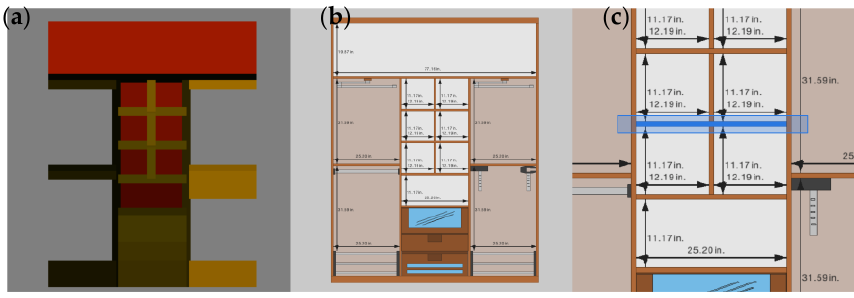
Figure 11. Expansion of the selectable surface of the several elements of a cabinet: ( a ) color information corresponding to the different selectable areas, ( b ) on-screen rendering, ( c ) graphical representation of the selectable surface of a shelf .